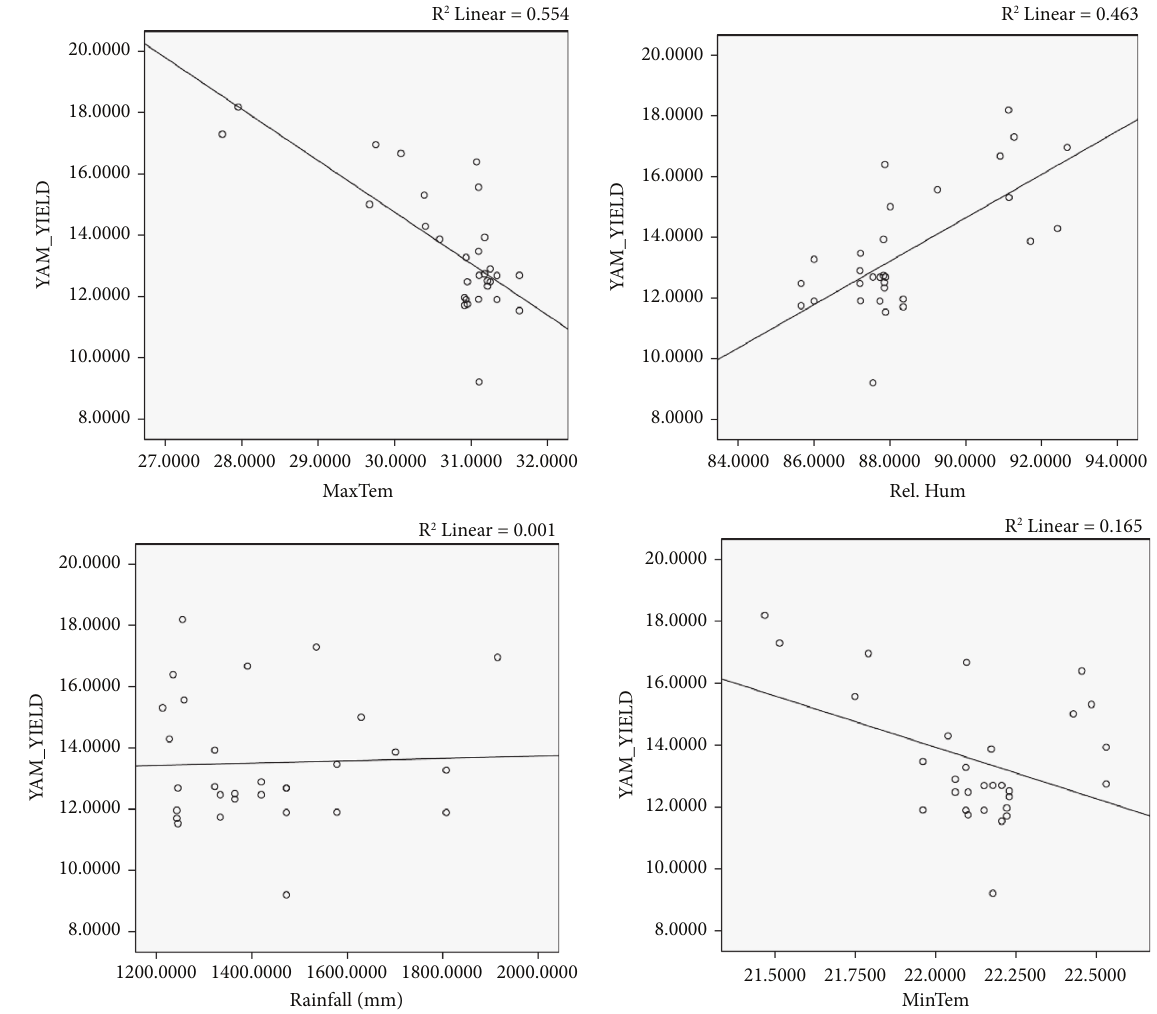
Figure 8: Scatter plot of yam yield on each climatic condition.